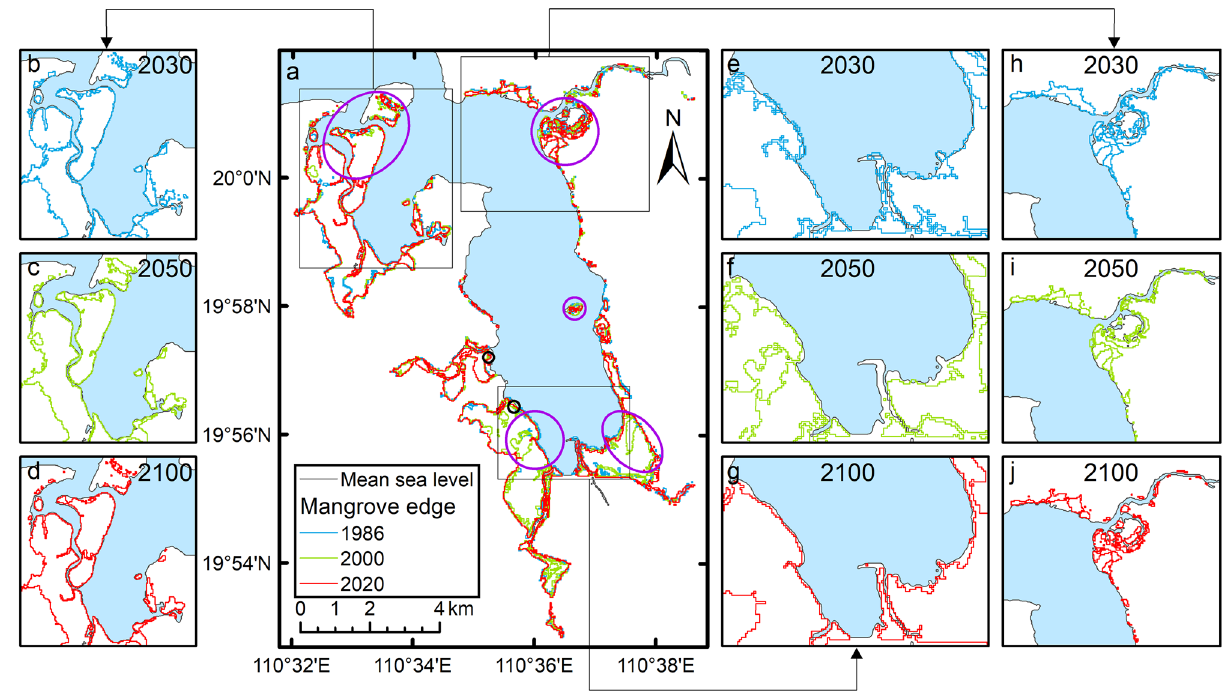
Figure 3. The dynamic changes in low mangrove edges in Dongzhaigang from 1986 to 2020. Maps generated in ArcMap v10.0 (https:// www. esri. com/ en- us/